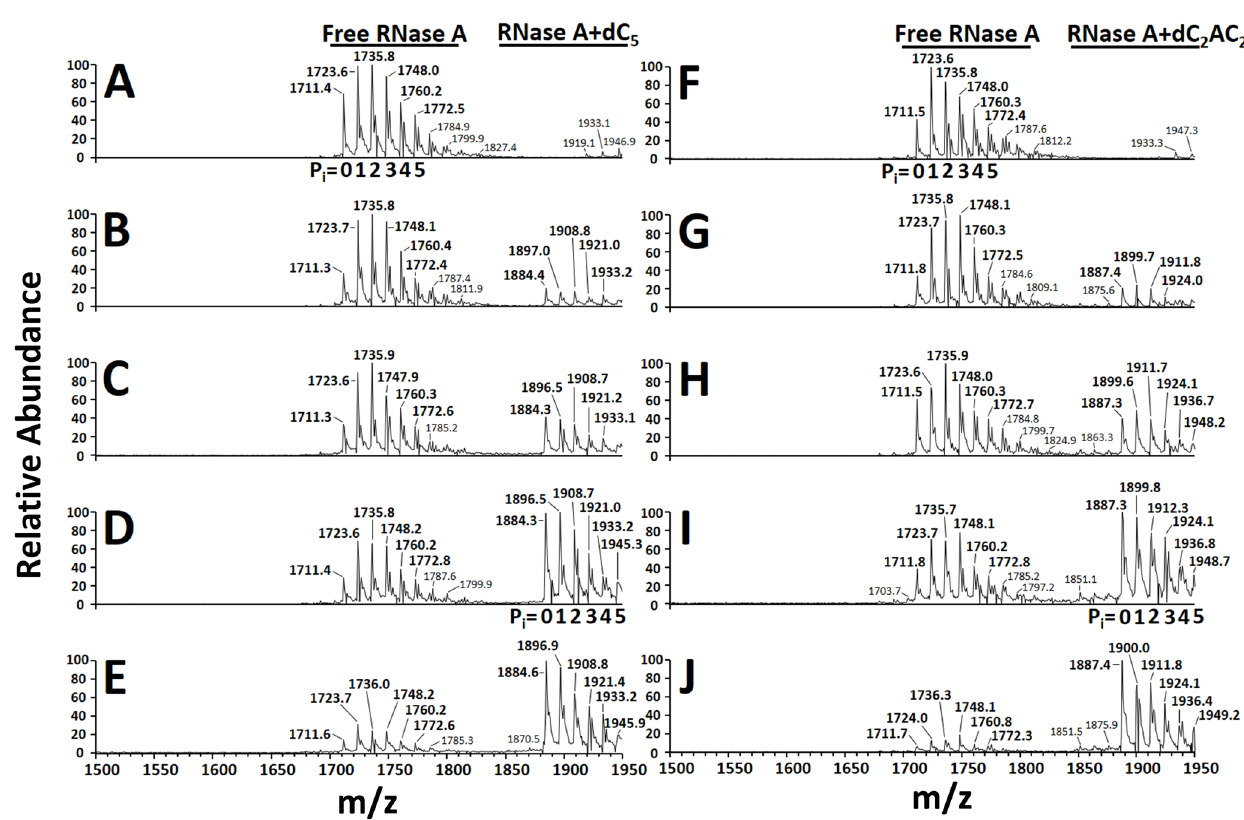
Figure 1. Mass spectra showing free RNAase A and ligand-bound forms as a function of added [deoxyoligonucleotide]. The +8 charge state is shown. ( A & F ) no added deoxyoligonucleotide, ( B ) 5 μM dC ( H ) 10 μM dC AC , ( I ) 20 μM dC AC , and ( J ) 40 μM dC 2 2 2 2 mass spectra ( A , D , F , and I ).